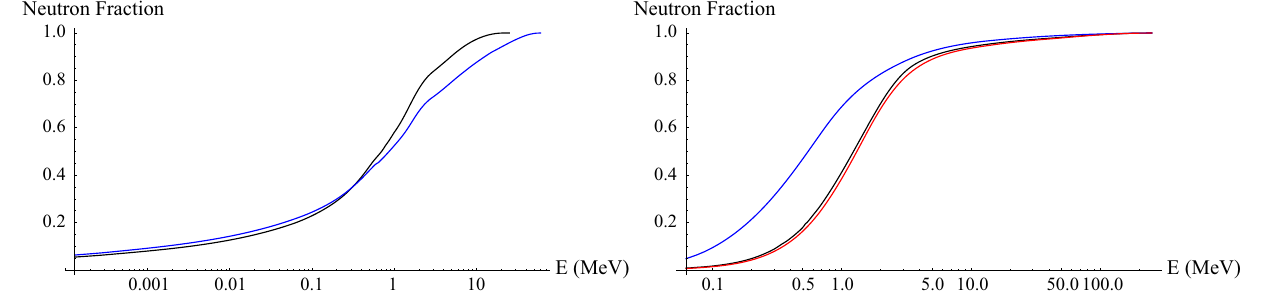
Fig. 5 The normalized cumulative distribution of the neutron energies upon exiting the target as produced using a 25 MeV (left panel, black), 60 MeV (left panel, blue) and 250 MeV (right panel) proton beam. The